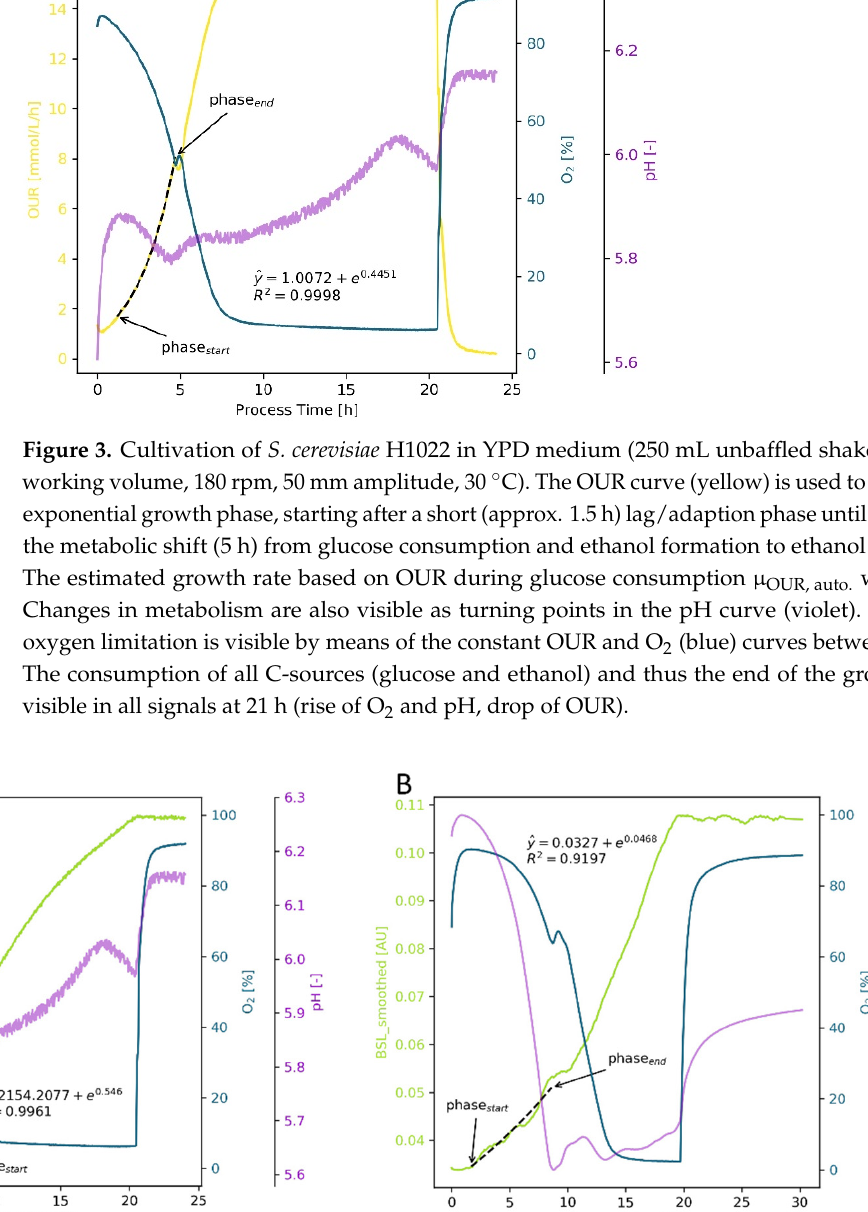
Figure 4. Comparison of backscattered light signals and growth rate estimations of S. cerevisiae H1022 in unbaffled 250 mL ( A ) and 500 mL flasks ( B ), cultivated at 30 °C in YPD medium. The BSL signal (light green) in the 250 mL flask ( A ) could be used without a filter and provided a fairly good result (µ BS, auto. is 0.546 h − 1 ). However, using the BSL signal in the 500 mL flask ( B ), even after smooth- ing the signal, was not sufficient to obtain a realistic calculation of the growth rate (neither manually nor algorithm-based).